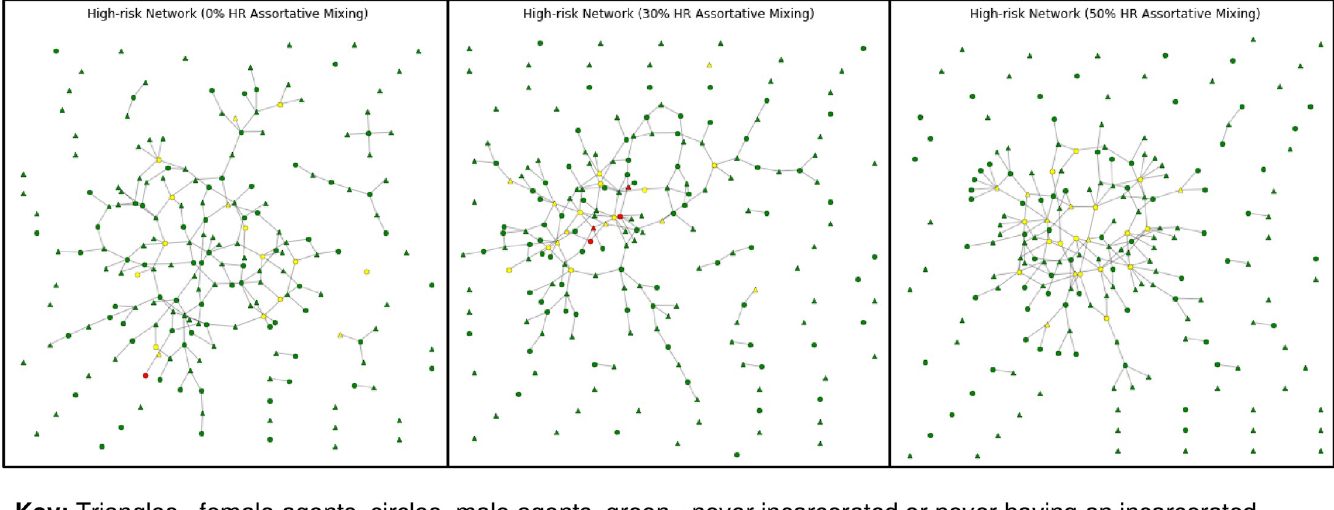
Fig 3. Network sample with 200 agents at year 10 at varying levels of assortative mixing.